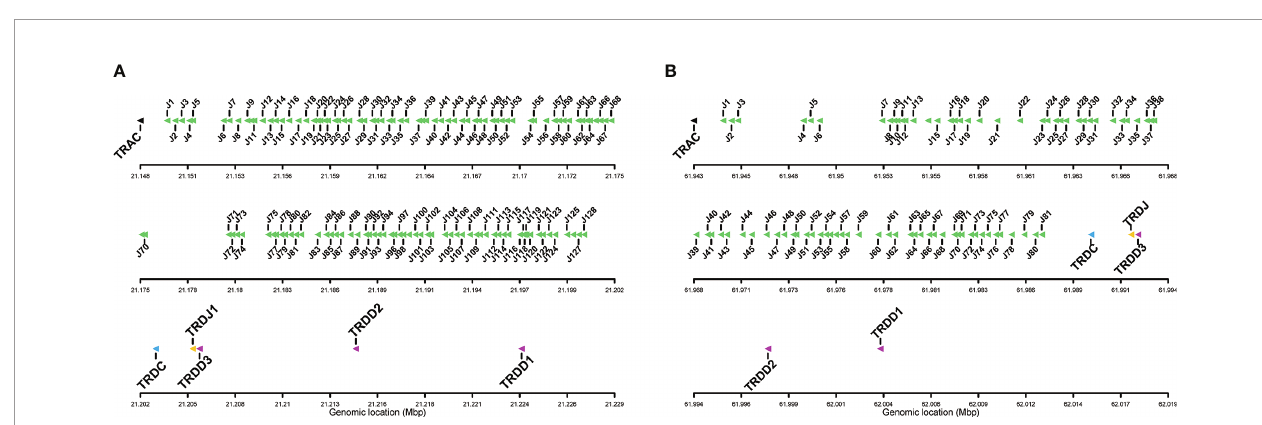
FIGURE 2 | Detailed view of the TRAJ cluster and the TRD genes, including TRDC, TRDJ and TRDD genes. (A) Salmo salar and (B) Oncorhynchus mykiss , Arlee line. The boxes representing the genes are not to